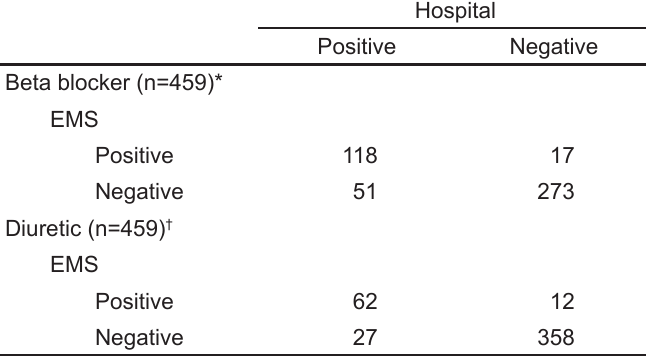
Table 2. Sensitivity and specificity of emergency medical services (EMS) report for medication